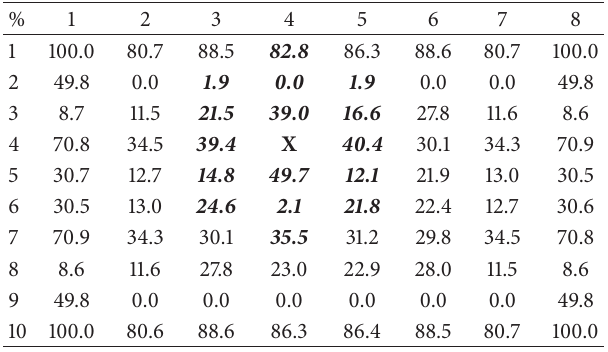
Table 3: Optimal heater power distribution with the damaged heater.